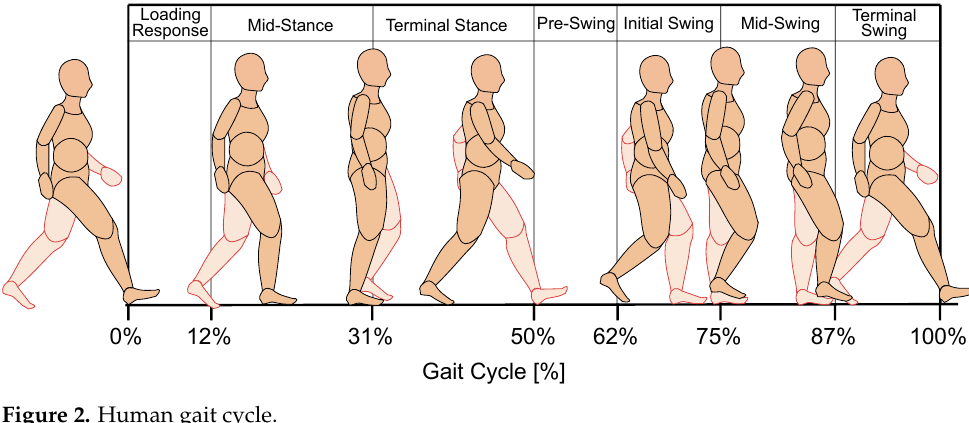
Figure 2. Human gait